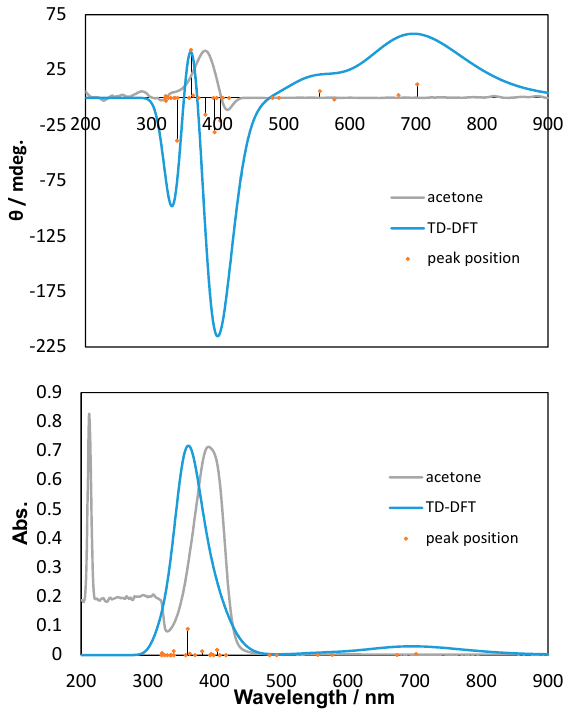
Figure 3. Experimental (in acetone solution) and simulated (UB3LYP/6-31G(d)) UV-Vis and CD spectra of Ni .